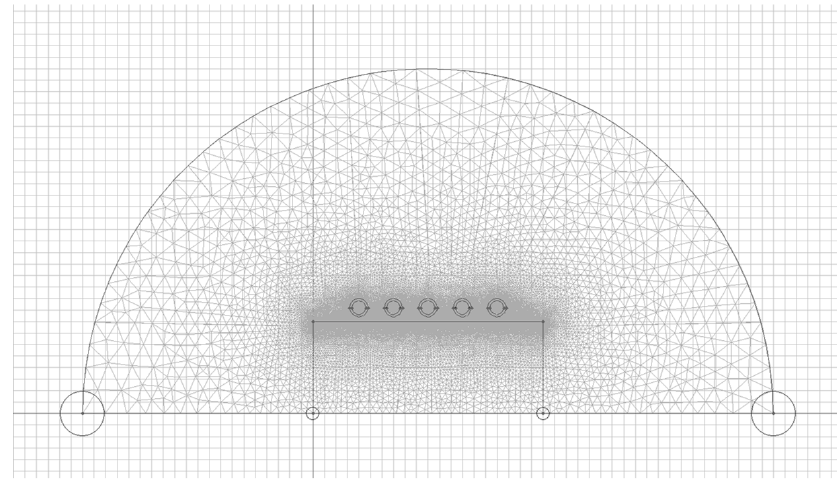
Figure 2. Discretization of the investigated system.